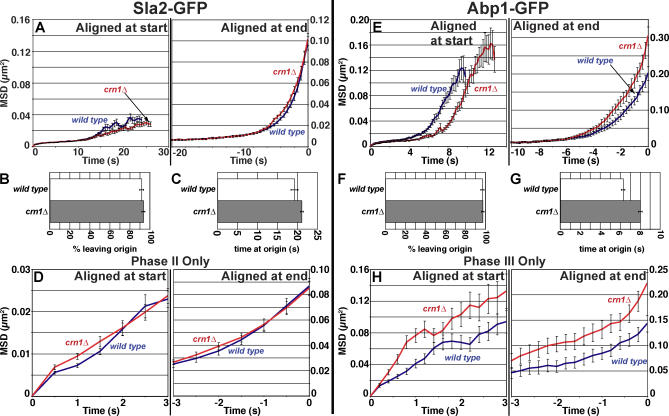
Quantitative Motion Analysis of Actin Patches in Null Mutants Lacking Coronin, Crn1Cells express Sla2-GFP (A–D) or Abp1-GFP (E–H). (A and E) MSD plots for wild-type and mutant patches aligned at the start (left) or end (right) of their lifetimes. The curves on the left are truncated at the median lifetime. (B and F) Percentage of patches that leave the origin. Mean of values for three segregants. (C and G) Average time at the origin, from the appearance of a patch until it moved away or disappeared. (D) Phase II movement only. For each patch, data prior to movement were removed. Only patches that moved away from the origin were included. (H) Phase III movement only. For each patch, data prior to the time the patch traveled 200 nm were removed. Only patches that moved more than 200 nm from the origin were included.Strain numbers and number of patches: (A–C) Wild-type, YJC5449 - 51; 177, 192, 173. crn1Δ, YJC5446–8; 155, 202, 147. (D) Strains as in (A–C). Numbers of patches: wild-type – 165, 182, 152. crn1Δ – 143, 184, 142. (E–G) Wild-type, YJC4297–9; 74, 62, 57. crn1Δ, YJC4235, 6 & 9; 88, 74, 72. (H) Strains as in (E–G). Numbers of patches: wild-type – 67, 59, 49. crn1Δ – 84, 68, 69 Error bars are ± standard error.